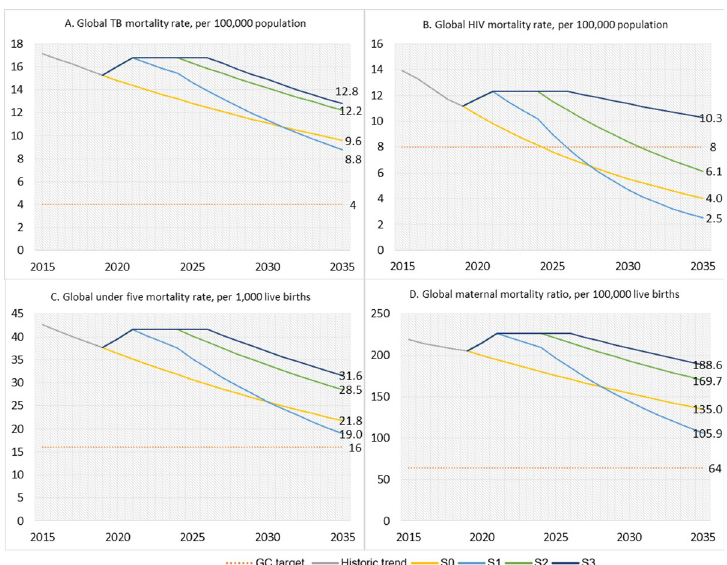
Fig 1. Projected global HIV, TB, and U5MRs and the global MMR under 4 different scenarios (S0–S3). Data sources that we used to estimate historical mortality rates from 2000 to 2019 included all age mortality rates for HIV and TB from the Institute for Health Metrics and Evaluation’s Global Burden of Disease Study (2000–2019) by country and year (http://ghdx.healthdata.org/gbd-results-tool); U5MR from 2000 to 2019 from the World Bank by country and year (https://data.worldbank.org/indicator/SH.DYN.MORT); MMR from 2000 to 2017 from the World Bank by country and year (https://data.worldbank.org/indicator/SH.STA.MMRT); and population estimates from the United Nations Population Division (https://population.un.org/wpp/). G AU : NewentrieshavebeenaddedtotheabbreviationlistofFig 1 : Pleaseverifythattheyarecorrect : C, grand convergence; MMR, maternal mortality ratio; TB, tuberculosis; U5MR, under-5 mortality rate.